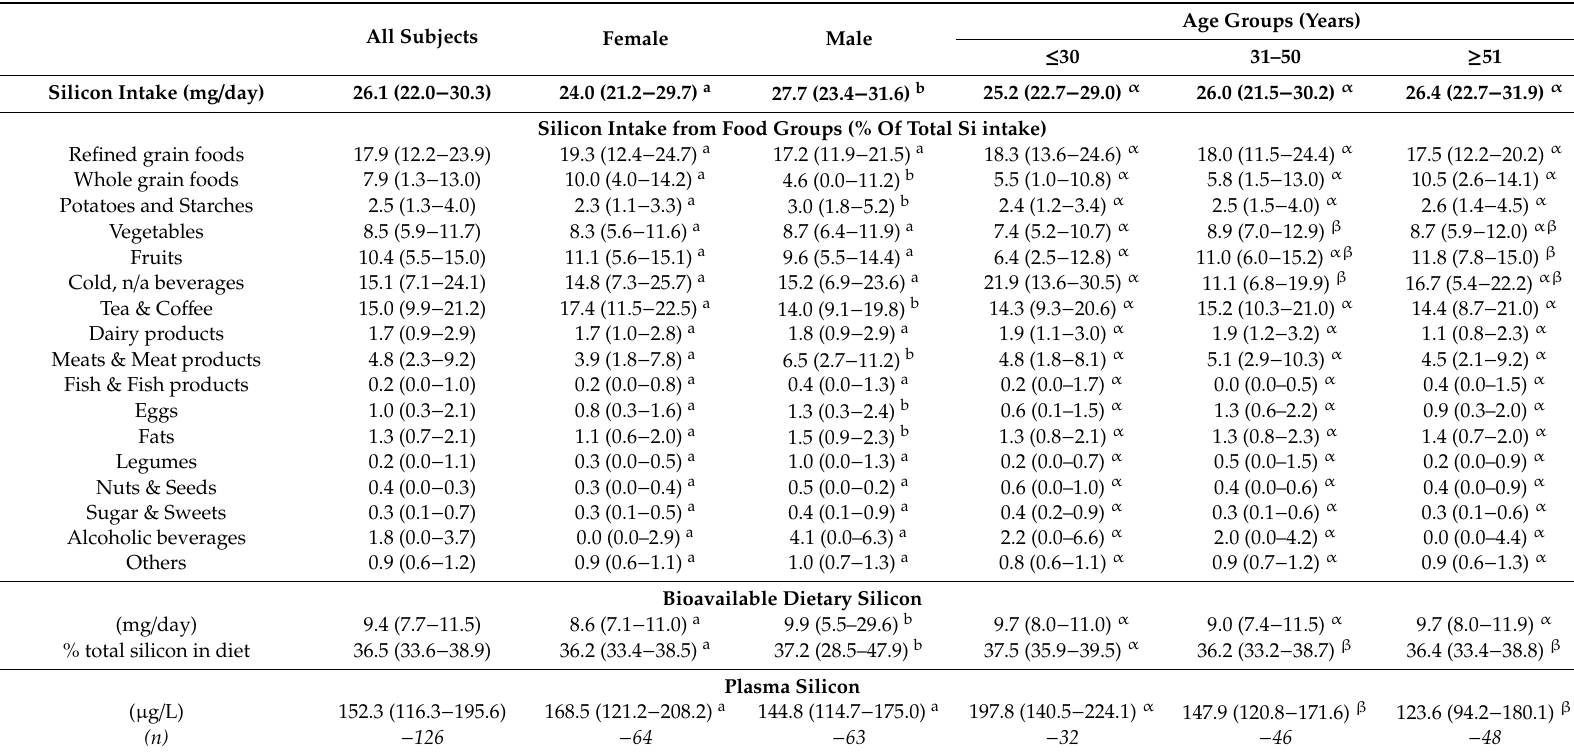
Table 4. Total silicon intake, contribution of food groups to silicon intake, bioavailable Si in the diet, and plasma silicon, median